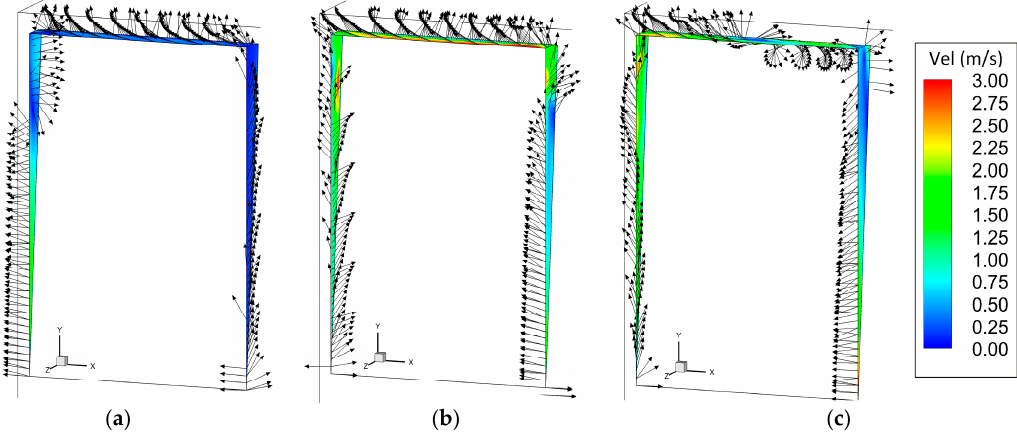
Figure 16. Vectors and velocity magnitude on the window opening for ( a ) 6 m / s, ( b )10 m / s, ( c )15 m / s wind speed, with a wind direction of 215 ◦